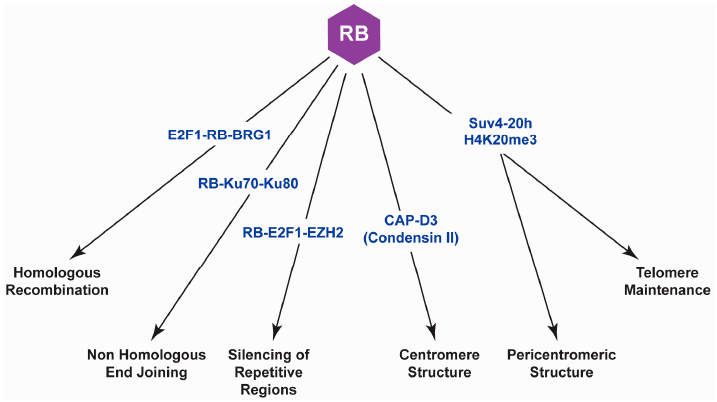
Figure 2. Retinoblastoma (RB) plays important roles in multiple processes unrelated to cell cycle control which, when defective, promote genomic instability.